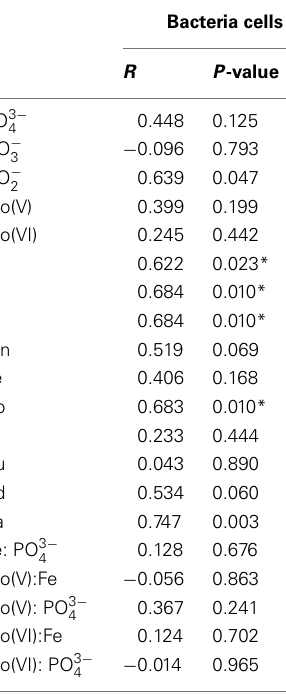
Table 4 | Correlation analysis between biological parameters and in situ nutrient